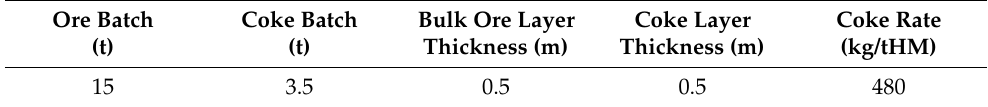
Table 4. Operation condition of BF (430 m 3 ) in plant